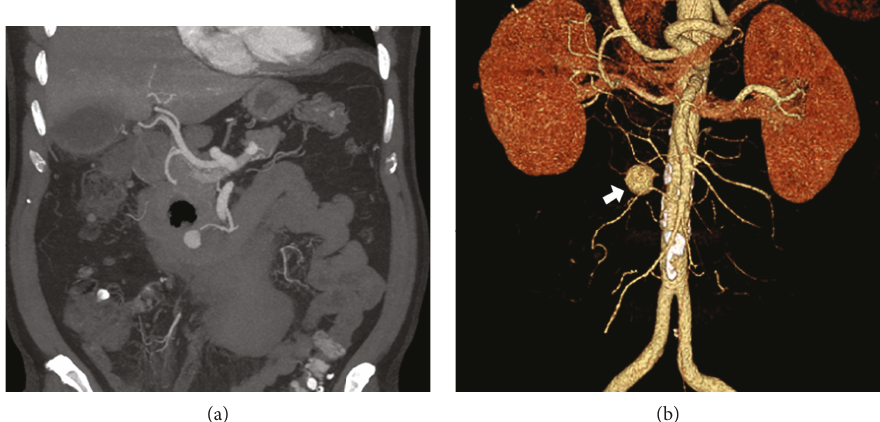
Figure 2: (a) Follow-up CT-scan: improved right upper quadrant in fl ammation, duodenal diverticulum (arrow), expanding pseudoaneurysm (arrow). (b) Angiography reconstruction: large pseudoaneurysm (arrow) of the pancreaticoduodenal artery.